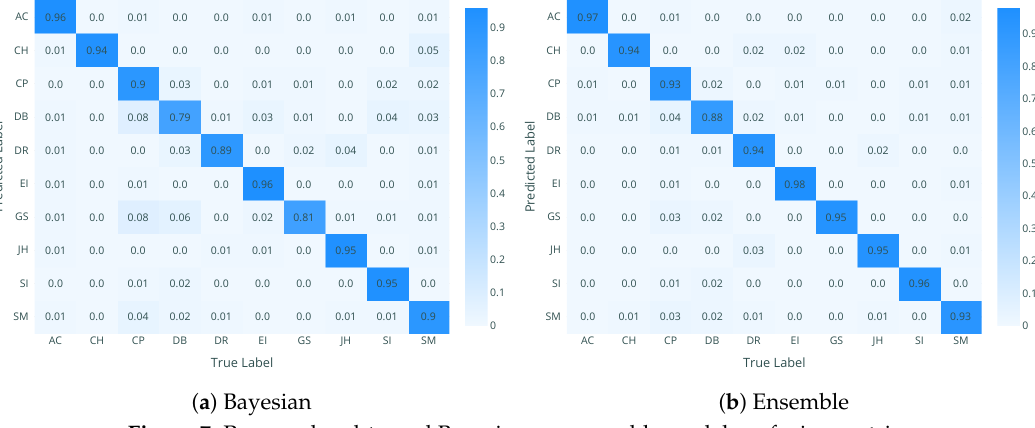
Figure 7. Proposed end-to-end Bayesian vs. ensemble model confusion